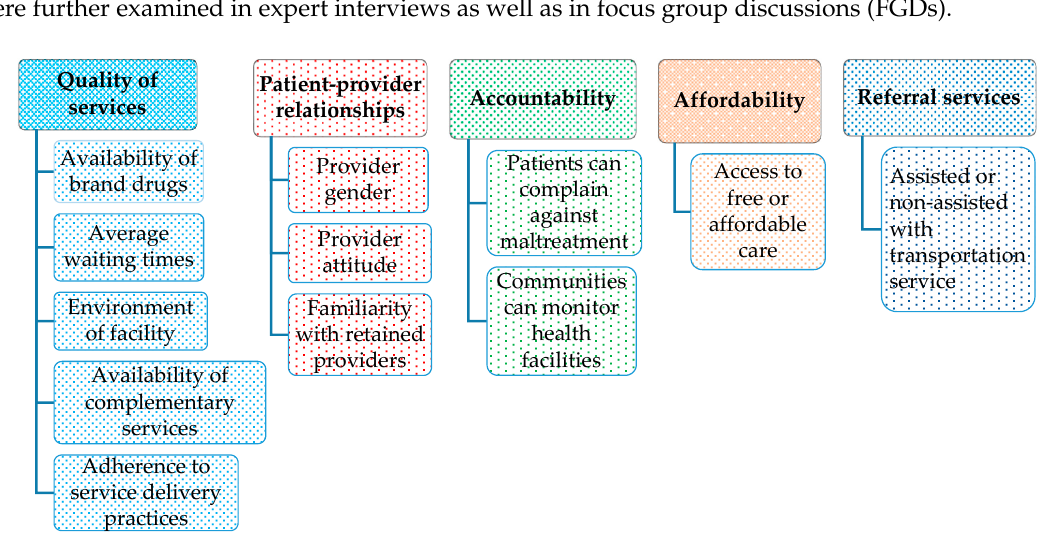
Figure 2. The attributes identified during the literature review.